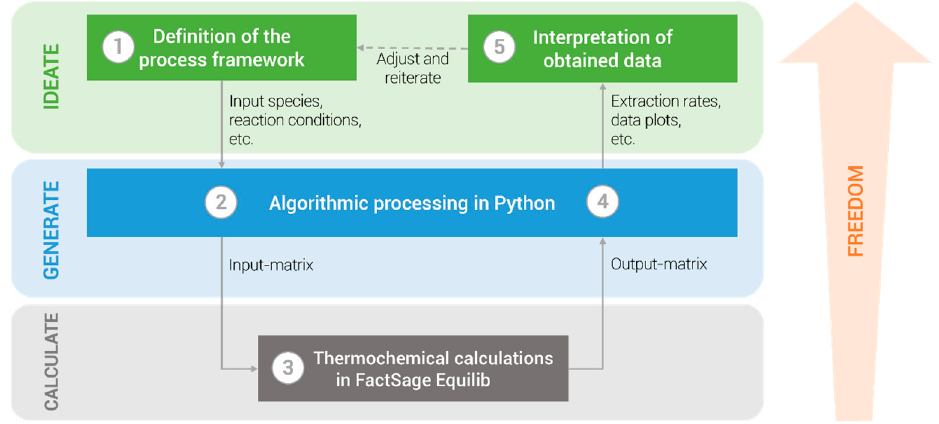
Figure 1. Schematic visualization of the modelling approach .